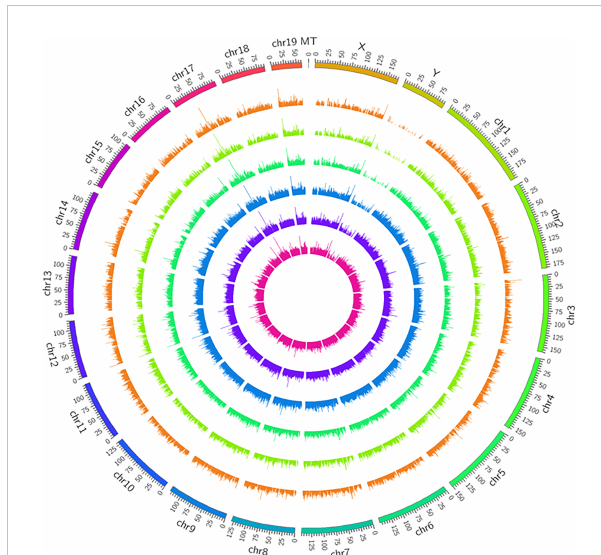
DEmRNAs on mice chromosomes. The outermost layer of the circos plot is the chromosome map of the rat genome. The largest and larger inner circles represent all DElncRNAs detected by RNA- sequencing with fold change ≥ 2.0, p < 0:05, and FDR < 0.05. The increased or decreased lncRNAs are marked with red or green bars, respectively, and bar heights in the larger inner circle indicate numbers of DElncRNAs. The smaller and smallest inner circles represent all DEmRNAs detected by RNA-sequencing with fold change ≥ 2.0, p < 0:05 and FDR < 0.05. Increased or decreased mRNAs are marked with red or green bars, respectively, and bar heights in the smallest inner circle indicate numbers of DEmRNAs.